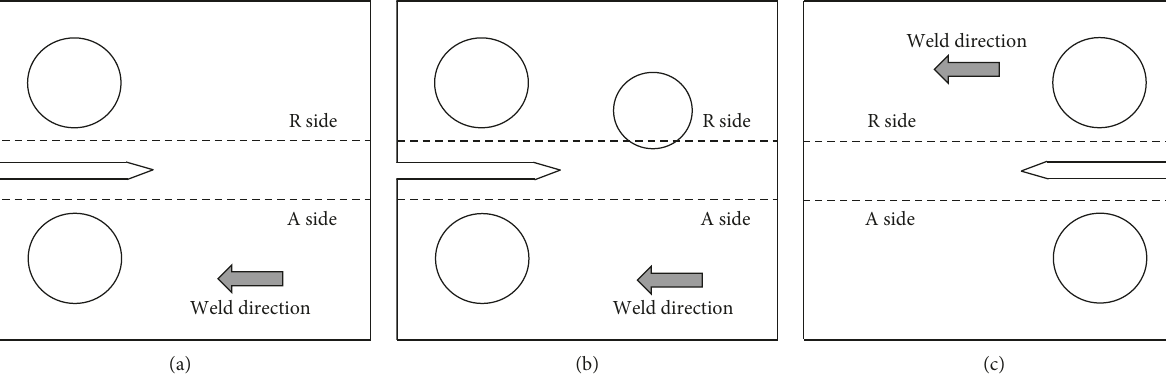
Figure 9: FSWed samples with welding direction heading to left. (a) Sample 4. (b) Sample 5. (c) Sample